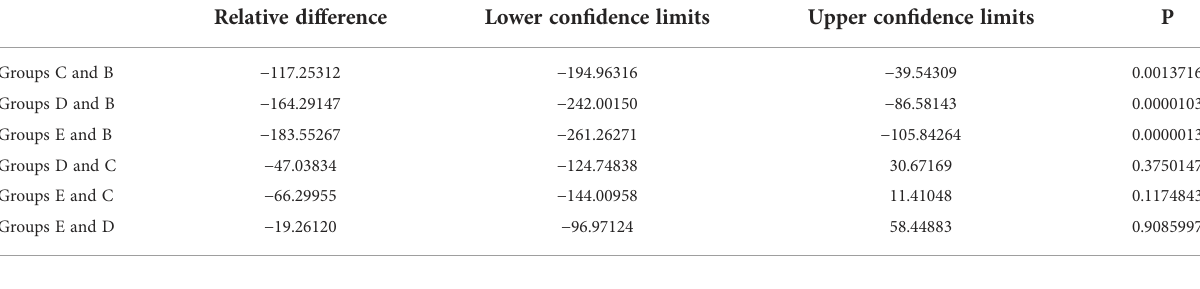
TABLE 11 Results of ANOVA of IL-17A.